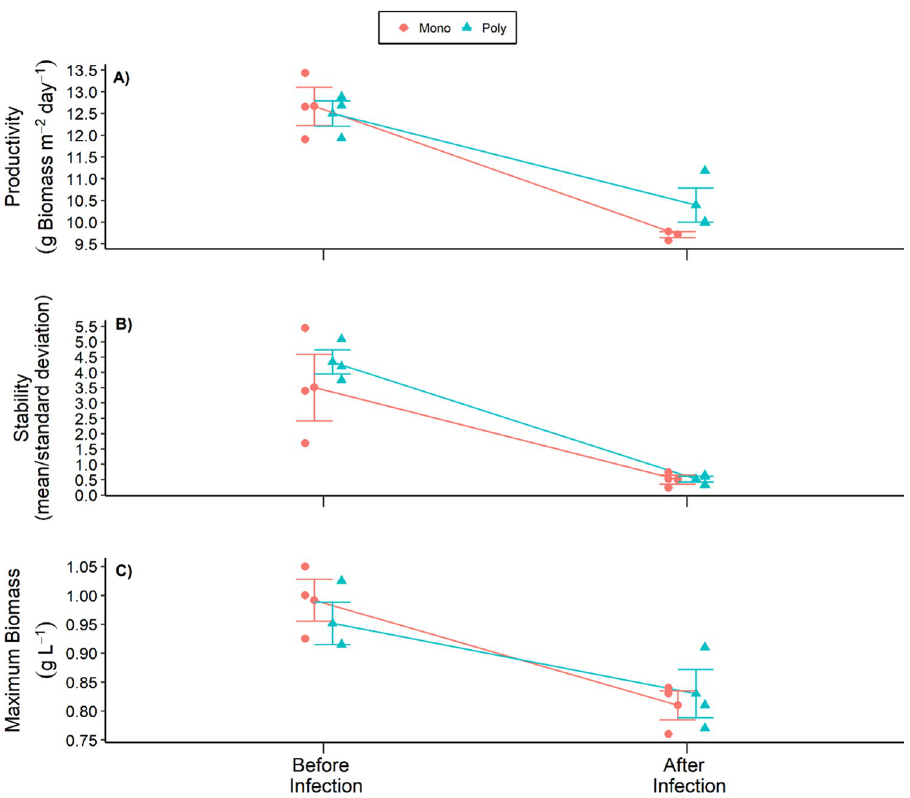
Fig 2. Mean production metrics of algal cultures before and after infection. Mean values for productivity (A), stability (B), and maximum biomass achieved immediately prior to harvest (C). Central data points with error bars show the grand mean of all replicates for each treatment with standard error bars. Offset data points represent the mean values for each replicate pond.